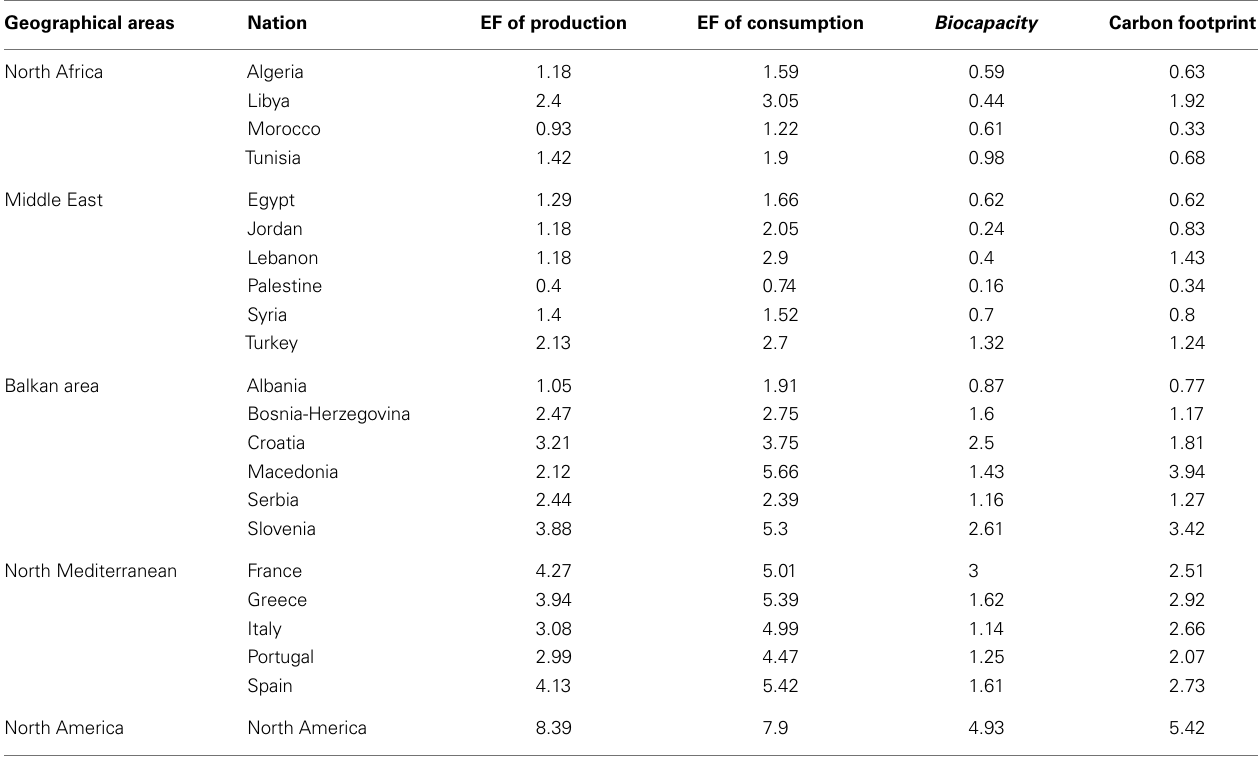
Table 1 | Ecological footprints of production and of consumption, biocapacity , and carbon footprint (in global hectares per capita) in the Mediterranean countries